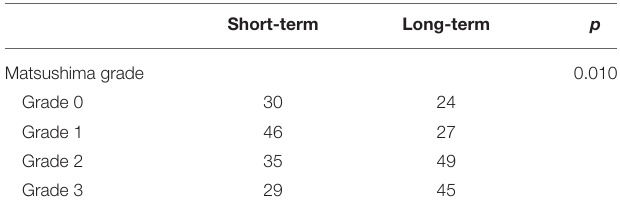
TABLE 1 | Baseline characteristics of patients. Patient characteristics